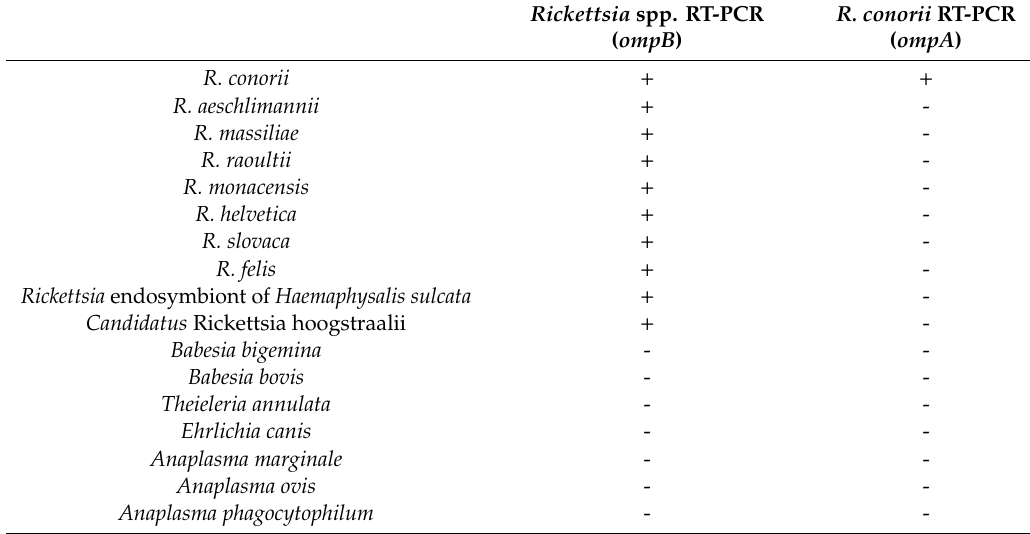
Table 1. Results of the amplification with the two new methods in the presence of DNA from di ff erent Rickettsia species and from other tick-borne